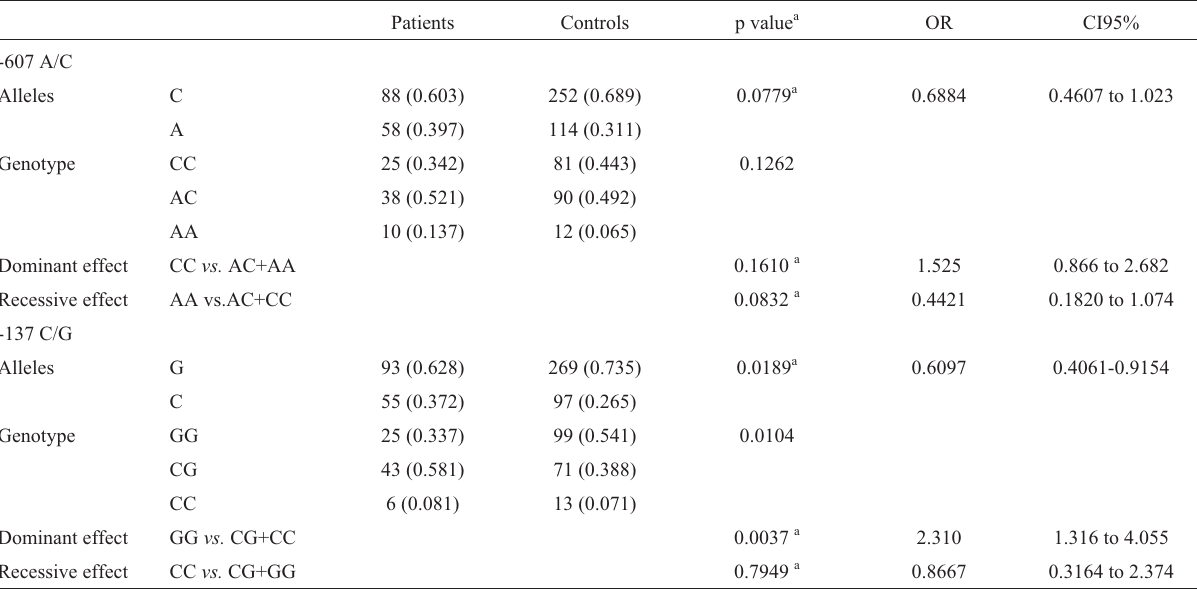
Table 3 - Allele frequencies and genotype distribution (%) of IL18 polymorphisms -607A/C and -137C/G in healthy controls and transplant patients. Patients